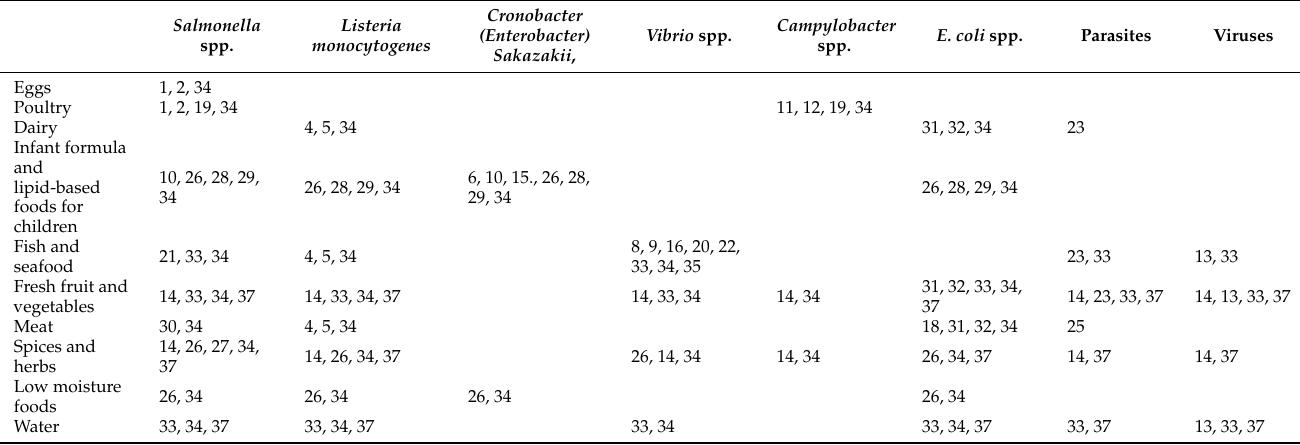
Table 2. Pathogen-commodity topics addressed by specific MRA series publication volume numbers.